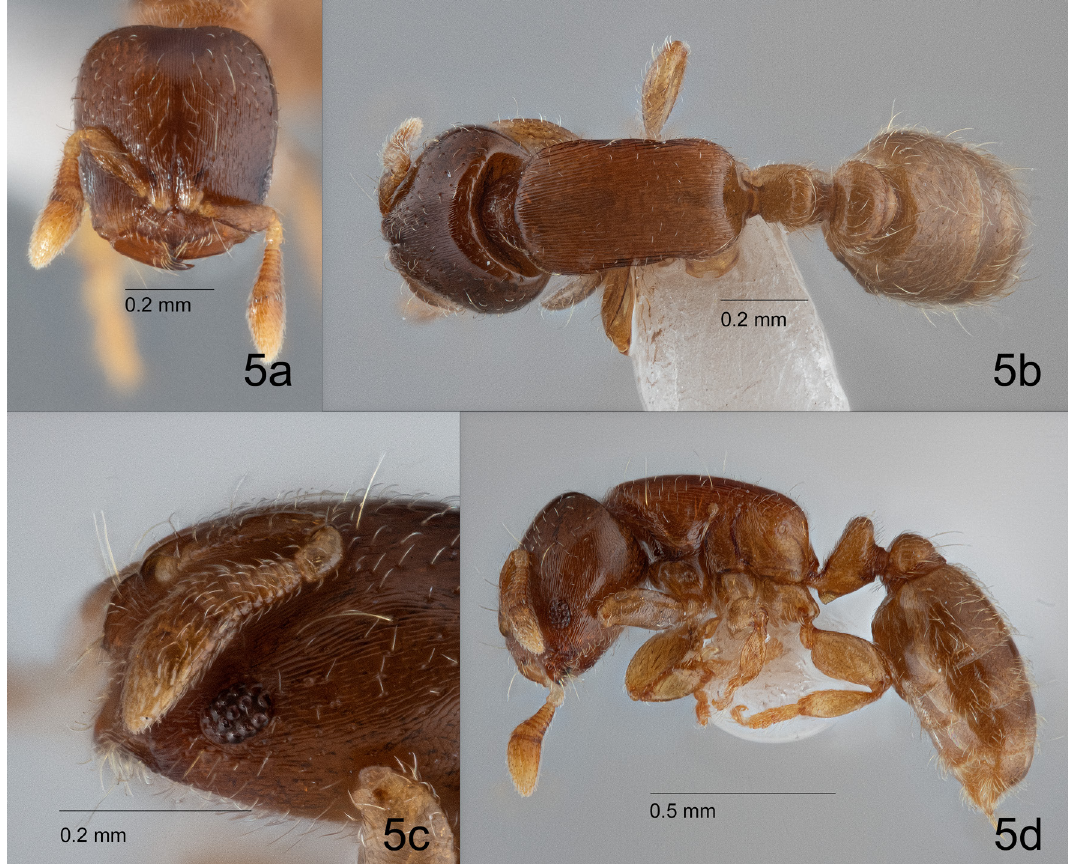
Fig. 5. Rhopalomastix javana Wheeler, 1929, non-type, worker, West Thailand (ZRC_ENT00000932). a . Head in full-face view. b . Body in dorsal view. c. Close-up of clypeus and head in profile. d . Body in lateral